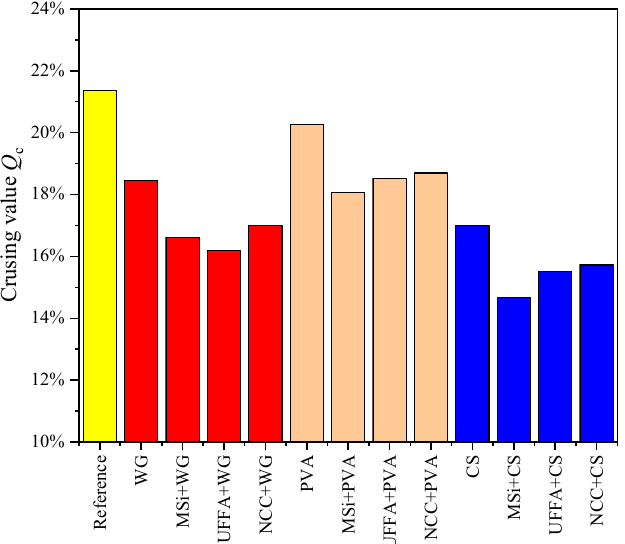
Figure 4. Crushing value Q c for recycled aggregates with different strengthening methods.